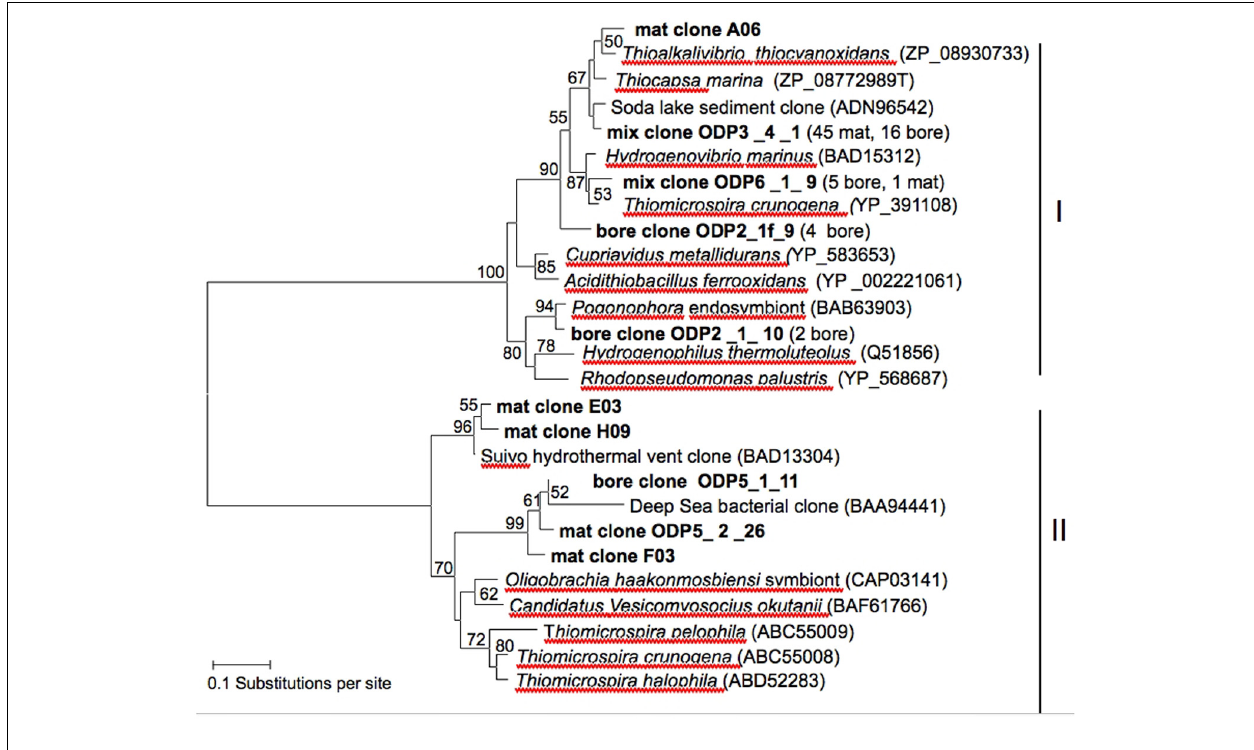
Bootstrap values (1,000 replicates) above 50% are displayed beside the nodes. Clone sequences are indicated in